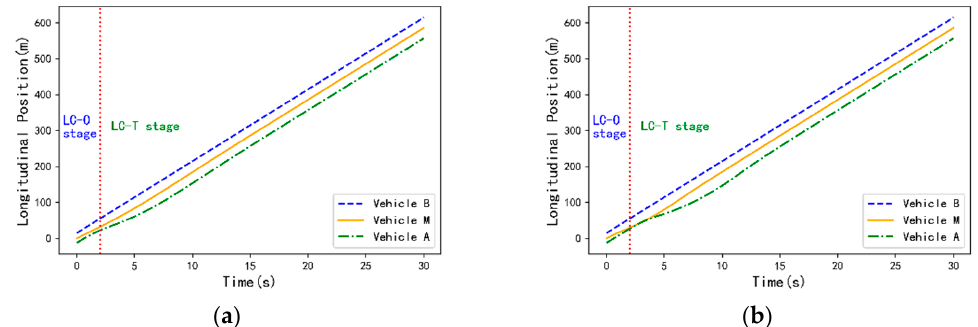
Figure 11. The longitudinal positions of vehicles B, M, and A of the two control strategies in scenario 2.